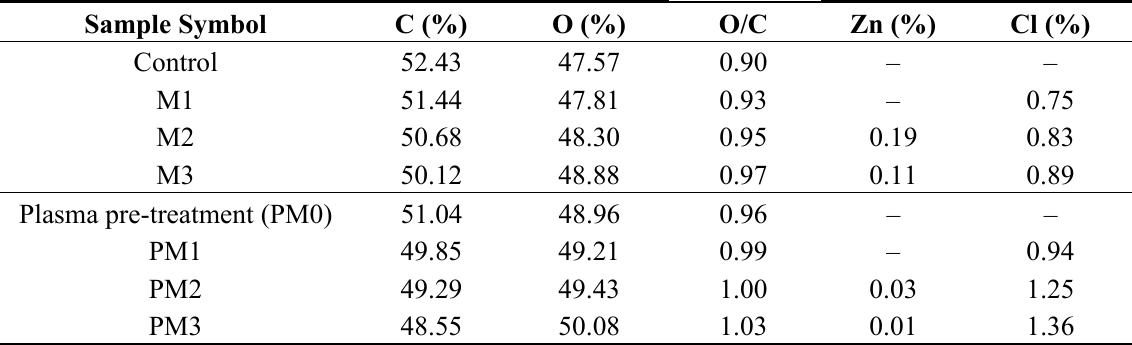
Table 3. The atomic percentage of different elements present in the anti-microbial treated cotton fabrics with or without plasma